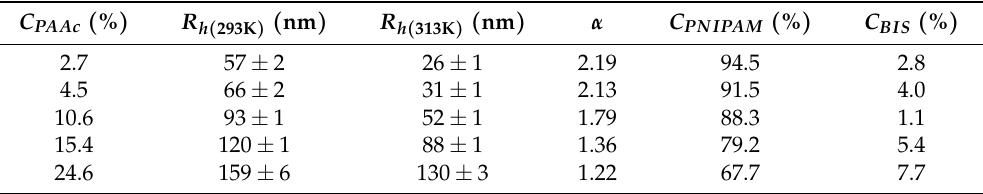
Figure 2. ( a ) DSC thermogram of an IPN microgel at C PAAc = 2.7%, C w = 0.9%, pH 5.5 and heat- ing rate 10K/min. The onset temperature is indicated by the intersection of the dashed lines. ( b ) Hydrodynamic radius R h , for the same IPN microgel, as a function of temperature measured in dilute conditions (C w = 0.01%). The dashed line indicates the onset temperature obtained from DSC measurements. Table 2. Characteristic parameters of IPN microgels at different PAAc contents at pH 5.5. R h is the particle hydrodynamic radius measured through DLS at T = 293K and T = 313K at weight concentration C w = 0.01%, α is the swelling ratio defined in the text through Equation (3), C PAAc , C PNIPAM and C BIS are respectively the contents of PAAc, PNIPAM and crosslinker BIS within particles measured through elemental and 1 H-NMR analysis